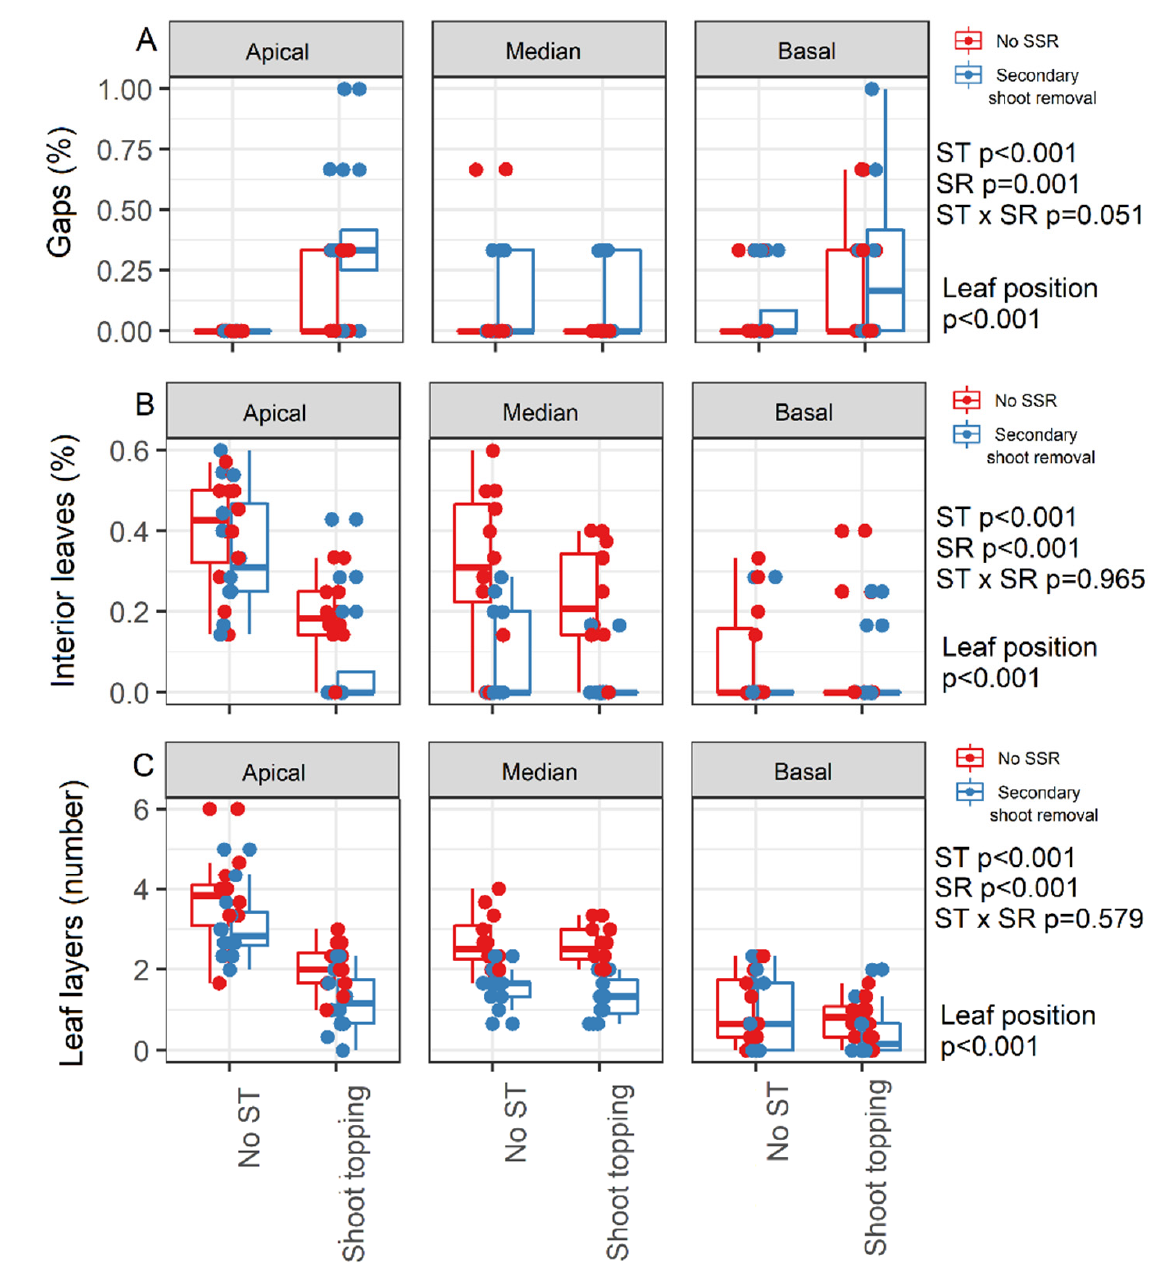
Figure 3. Gaps ( A ), interior leaves ( B ), and leaf layers ( C ) in plants subjected to shoot topping or shoot bundling (no ST) where secondary shoots were either removed (secondary shoot removal) or not (no SSR) (n = 24). In the graphs, points represent raw data, horizontal lines within boxes indicate the median, and boxes indicate the upper (75%) and lower (25%) quartiles. Whiskers indicate the ranges of the minimum and maximum values. Data were analyzed with two-way ANOVA while leaf position was evaluated as single factor with one-way ANOVA. p -values are shown in the graph (ST—shoot topping factor; SR—secondary removal factor; ST × SR—interaction).